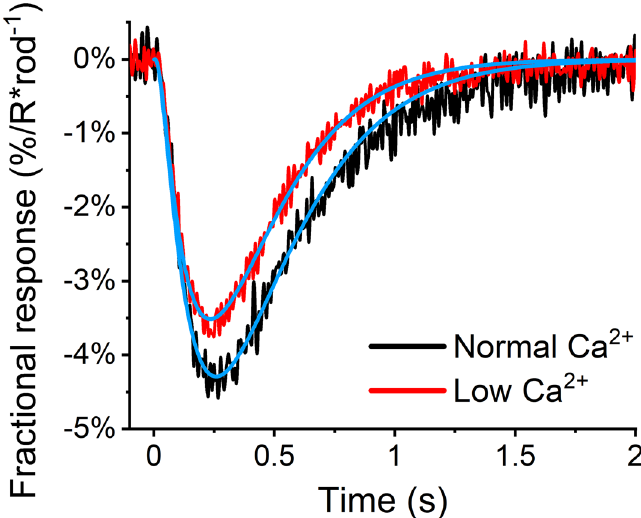
Figure 6. Determination of β dark by model fitting (described in the Material and Methods, Eqs. (12) – (14)) to GCAPs −/− recoverin −/− mouse dim flash responses recorded with LERG-OS in normal and in low Ca 2+ . The dim flash responses are normalized by the saturation amplitude and the stimulus strength to obtain fractional responses. The dim flash responses are population averaged from 10 experiments. Responses were always recorded first in normal and then in low Ca 2+ solution. The model fits are shown in light blue, and Table 2 shows the parameter values used in modeling.